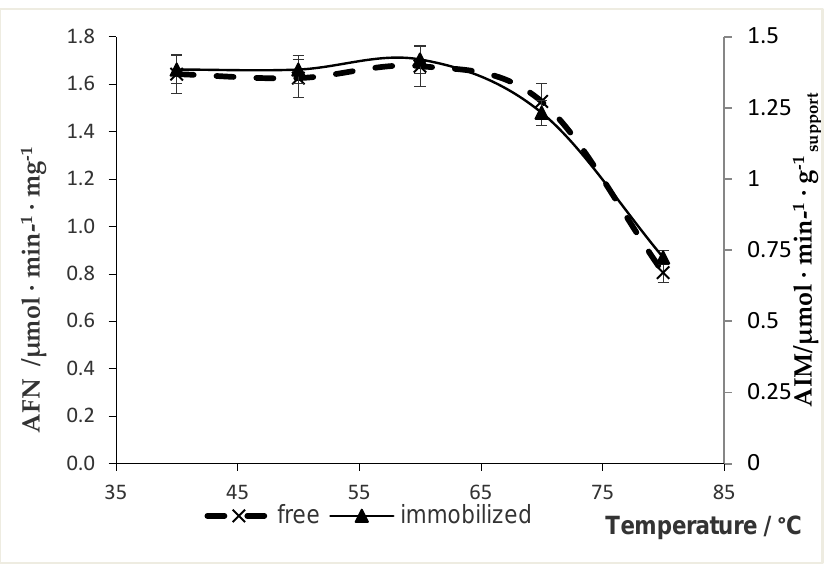
Figure 4. Thermal stability of free and immobilized naringinase. AFN—activity of free naringinase; AIM—activity of immobilized naringinase.